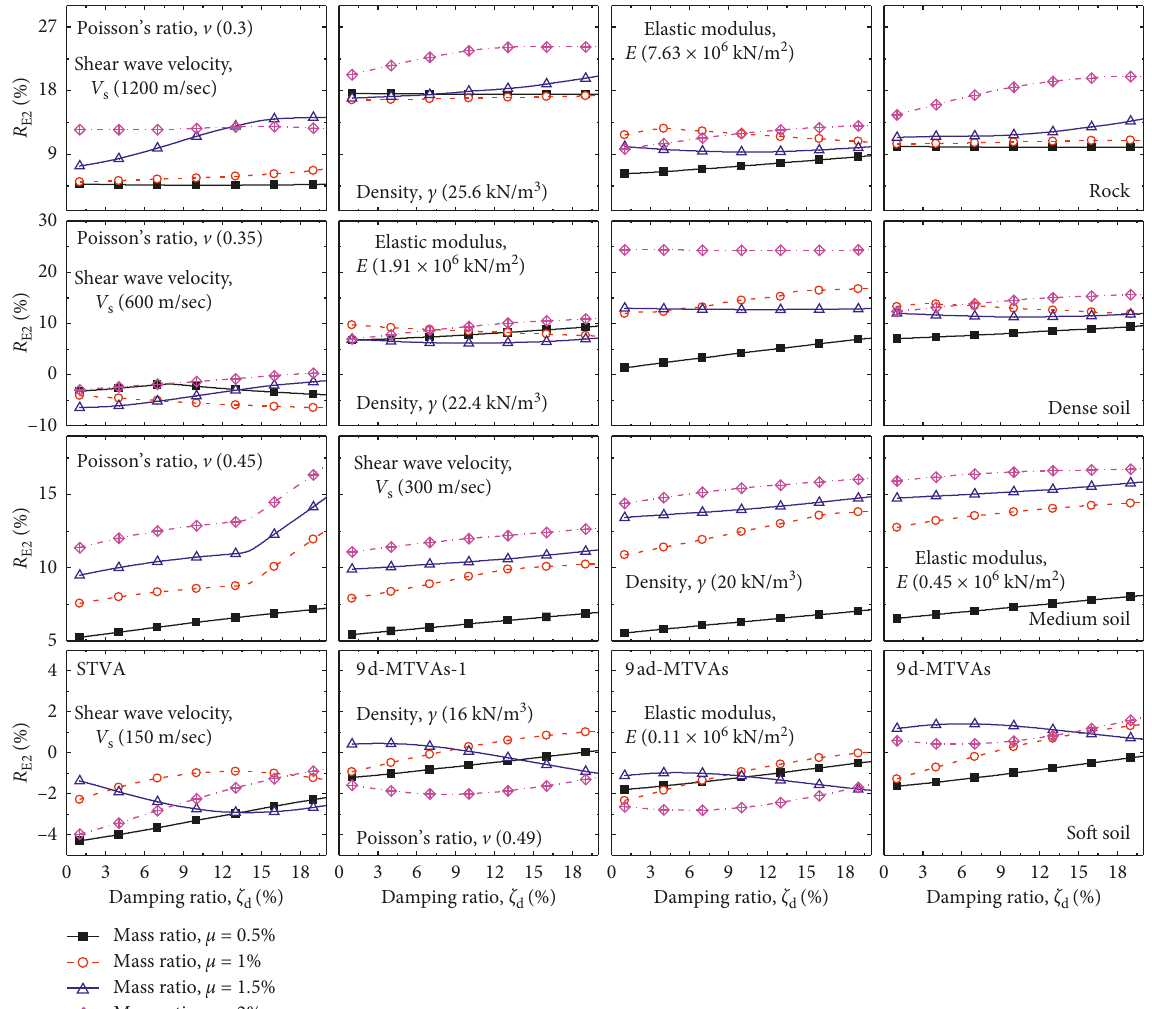
Figure 8: Variations of damping ratios ( ζ d ) for different mass ratios ( µ ) of the STVA, 9d-MTVAs-1, 9ad-MTVAs, and 9d-MTVAs installed on the chimney including SSI under Llolleo (1985) earthquake ground